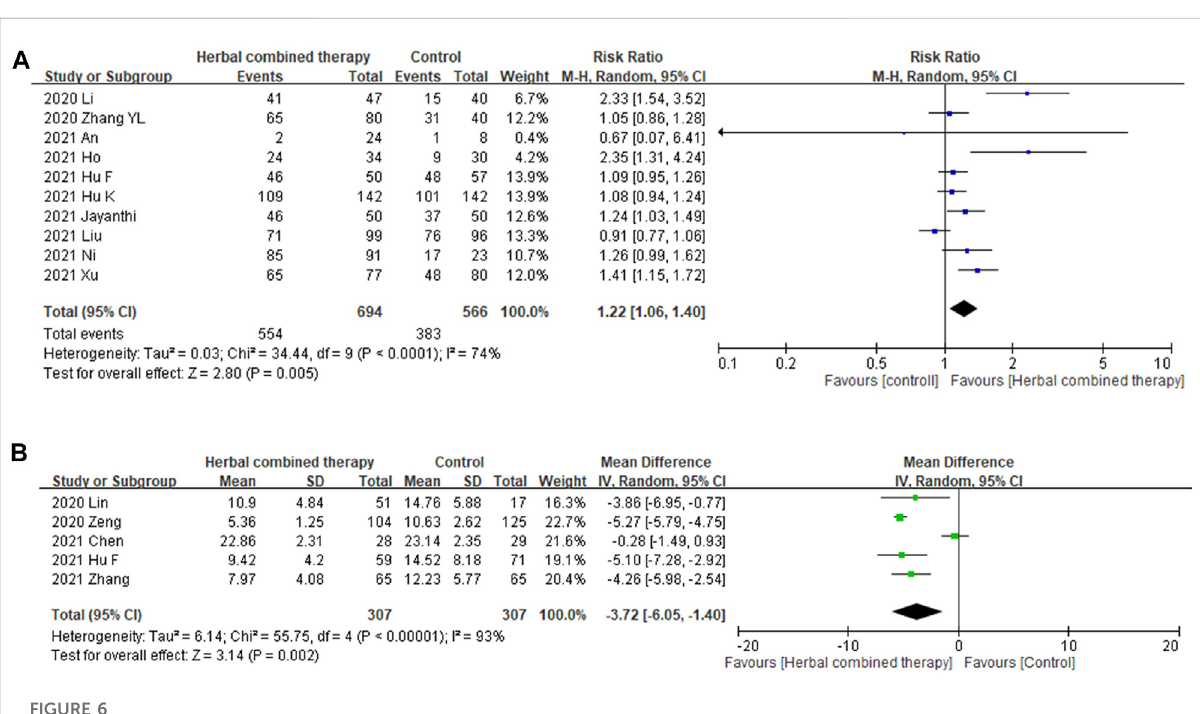
FIGURE 6 (A) : Forrest plot of the effects of HM combined therapy in viral conversion rate. (B) : Forrest plot of the effects of HM combined therapy in viral conversion time